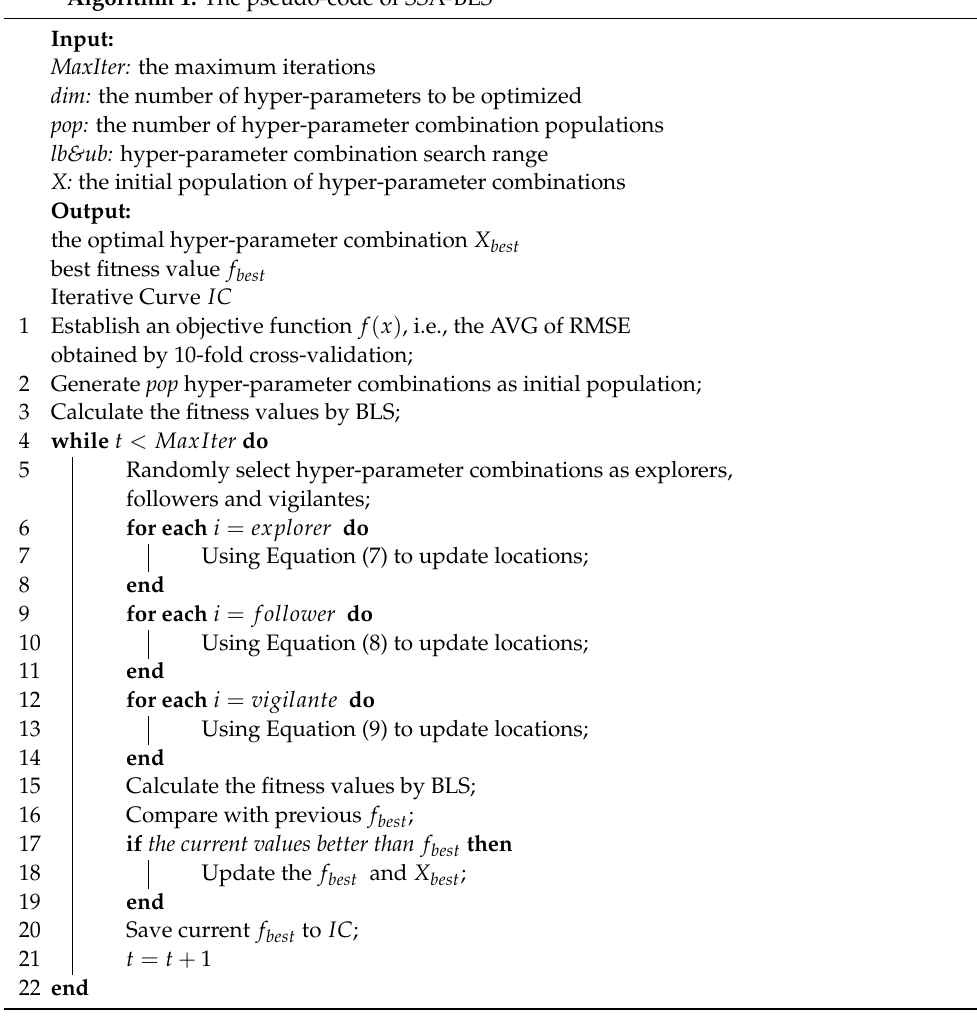
Algorithm 1. The pseudo-code of